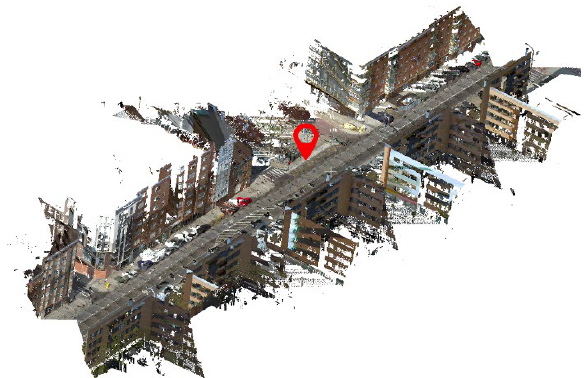
Figure 7. MLS point cloud of one street containing a bus stop (red mark)